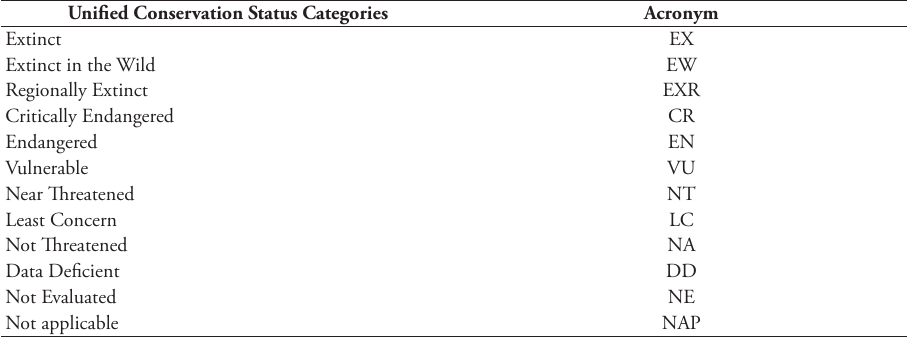
Table 1. Conservation categories applied for Argentina´s vertebrate